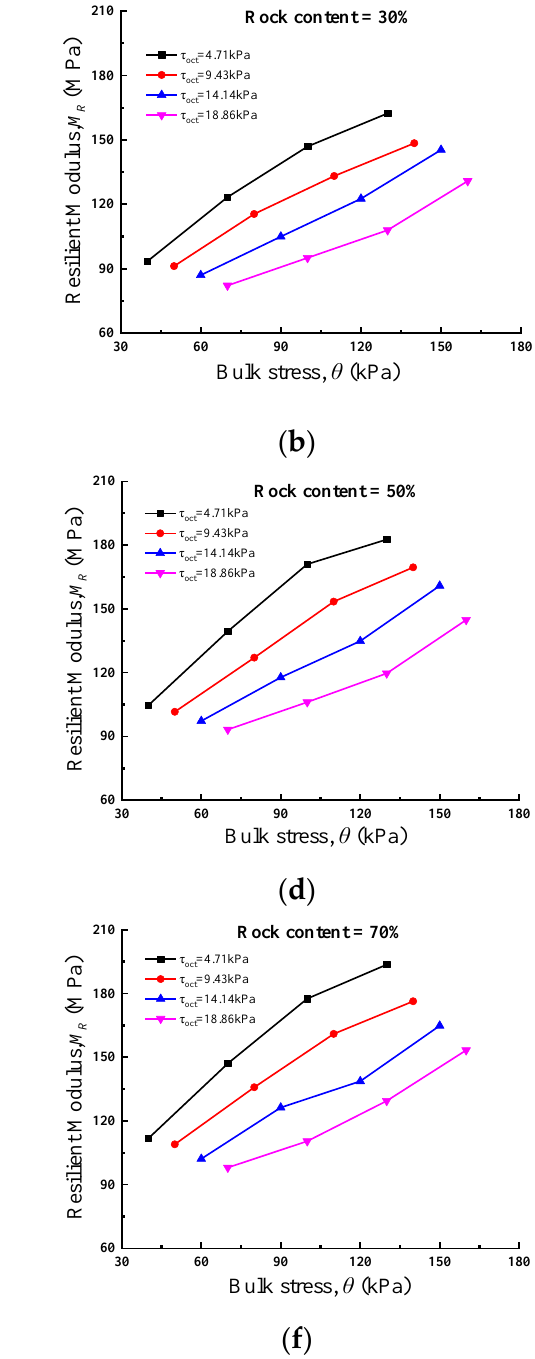
Figure 2. Relationship between bulk stress and resilient modulus with different R c : ( a ) 0%; ( b ) 30%; ( c ) 40%; ( d ) 50%; ( e ) 60%; ( f ) 70%.